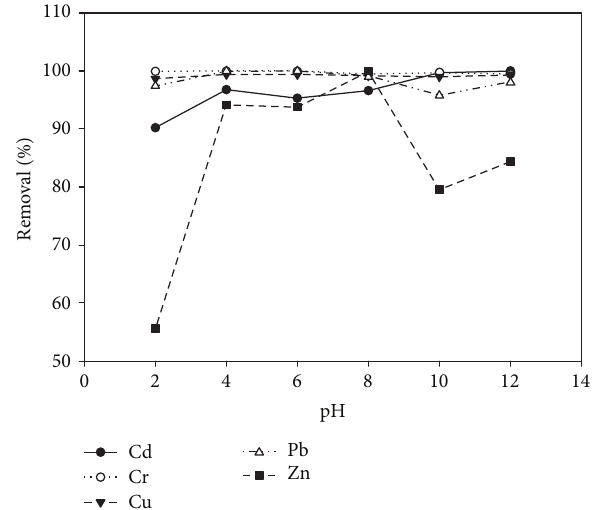
Figure 2: Percentage of heavy metals adsorbed plus any precipitated species at different pH for single component adsorption scenario [24].